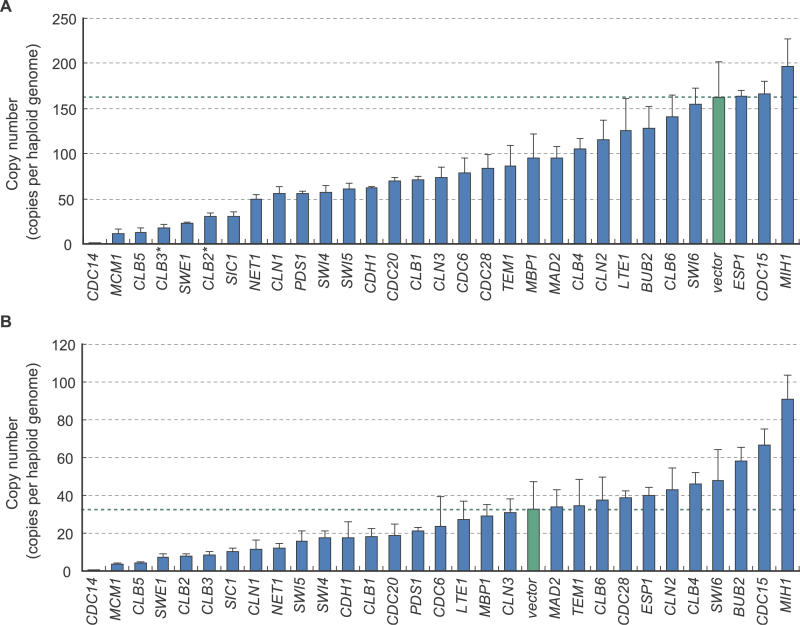
Upper Limit Copy Numbers of CDC GenesCopy number of the plasmid with each of the 30 CDC genes was determined in the gTOW experiment in leucine− (A) and uracil− (B) conditions. *The copy numbers of CLB3 and CLB2 were determined in the conditions with 40 μg/ml and 20 μg/ml leucine, respectively. The data used in the graphs are listed in Table S2.